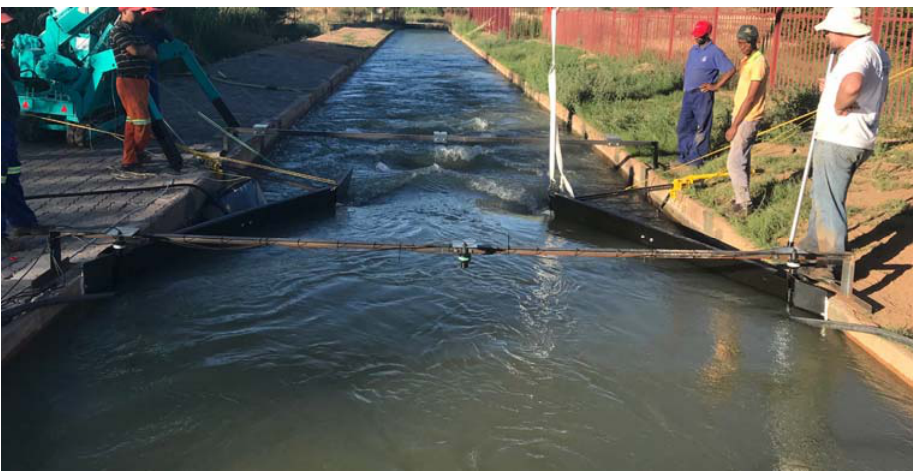
Figure 5. Turbine test